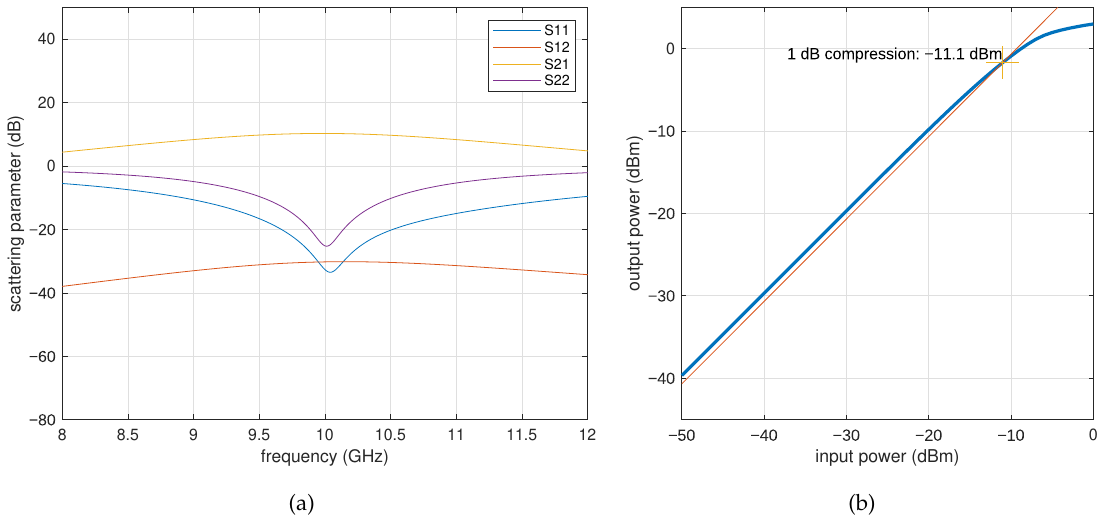
Figure 9. Simulations of the HPA input–output scattering parameters ( a ) and input-referred 1-dB compression point ( b ).